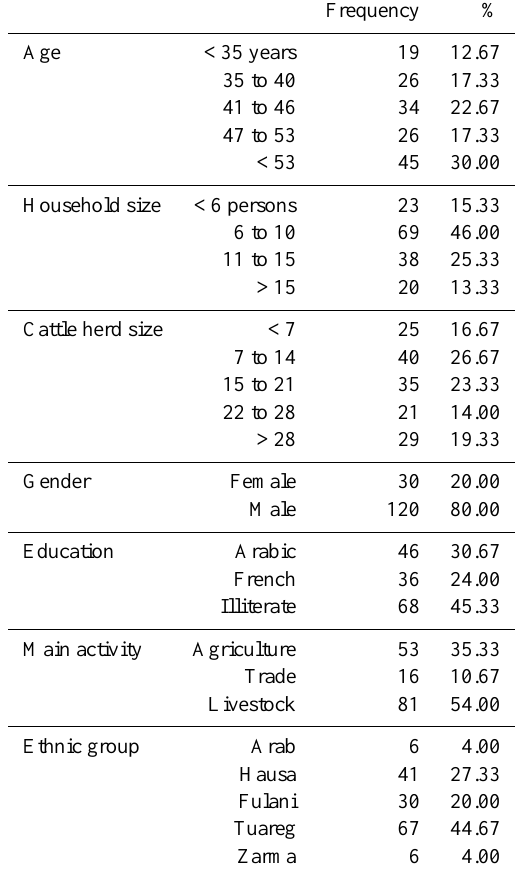
Table 2. Socioeconomic characteristics of surveyed Azawak breed- ers ( n =